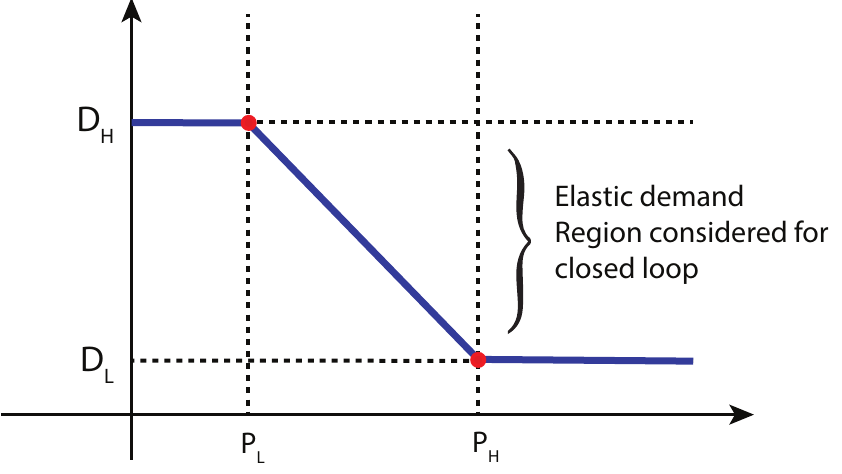
Figure 2. Important points for the estimation of price demand